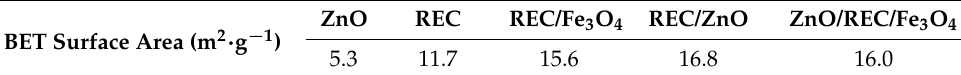
Table 1. Specific surface area of ZnO, REC, REC/Fe 3 O 4 (1:0.3), REC/ZnO (1:0.5), REC/Fe 3 O 4 /ZnO (1:0.3:0.5) powder.